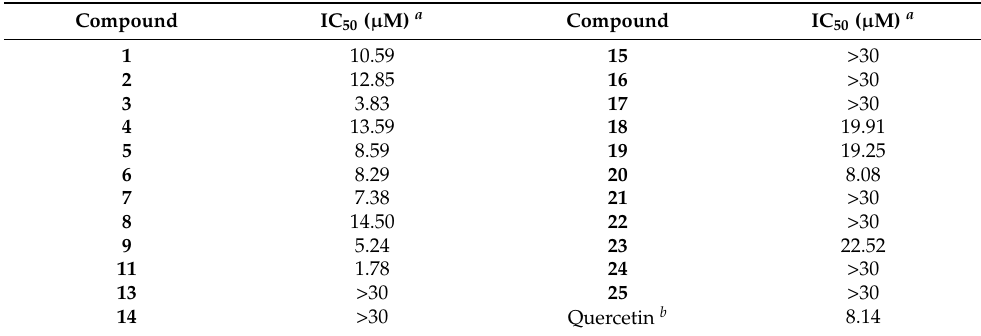
Table 2. IC 50 values of compounds isolated from the aerial parts of A . iwayomogi inhibiting NO production in BV-2